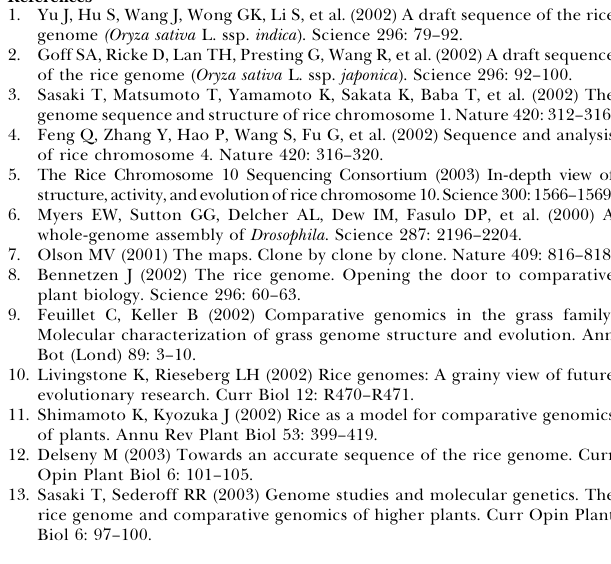
Table S1. Raw Data for Beijing indica and Syngenta japonica Assemblies Read length is the number of Q20 bases with an error rate of 10 (cid:1) 2 or better. Effective coverage is based on the depth of reads in contigs over 5 kb in size, ignoring regions with 20-mer repeats. Clone insert sizes are specified in terms of tenth and 90th percentiles. Found at DOI: 10.1371/journal.pbio.0030038.st001 (16 KB XLS). Table S2. Transposable Elements Identified with RepeatMasker Are Put into Classes I, II, and III As a result of our efforts to identify indica – japonica polymorphisms, the sequence is divided into four nonoverlapping categories: unassembled, assembled-but-unmapped, mapped-but-unaligned, and aligned (with all the SNPs). Found at DOI: 10.1371/journal.pbio.0030038.st002 (28 KB XLS). Table S3. Detailed Analysis of Gene Overlaps from Figure 3 For each region of the Venn diagram, we use BLAT to align the predicted gene to the other assembly (or assemblies) where the gene is supposedly missing. The objective is to determine whether it is the sequence that is missing, or whether the discrepancy is due to the errors in the ab initio predictions. What we find is a bit of both. However, fragmented sequence assemblies are not a problem. If the gene is found at all, it is usually found in one piece. What is striking is that predicted genes that are unique to the two WGS assemblies do tend to be genuinely missing from IRGSP japonica sequence. This supports the idea that the WGS method can sometimes identify genes that are not well represented in the BAC clone libraries. Table S4. Table of InterPro Domain Rankings One table compares predicted genes from Arabidopsis and Beijing indica . The second table compares predicted genes from Beijing indica with nr-KOME cDNAs.